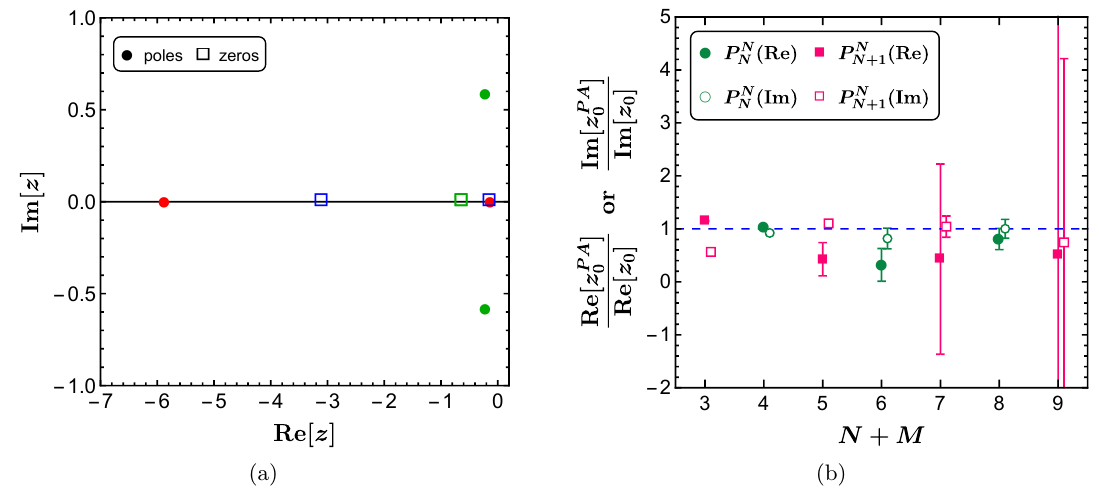
Figure 2 . (a) Poles (filled circles) and zeros (empty squares) of P 3 ( z ) fitted to the toy data set 4 generated from g ( z ) , eq. (3.1). The poles and zeros that can be identified with genuine poles of g ( z ) are in green, while artifacts are shown in red (poles) and blue (zeros). (b) Real and imaginary parts of the complex pole z PA predicted by the PAs, normalized to their corresponding true value, 0 for approximants belonging to the sequences P N ( z ) and P N ( z ) , as a function of the number of N N +1 parameters of the